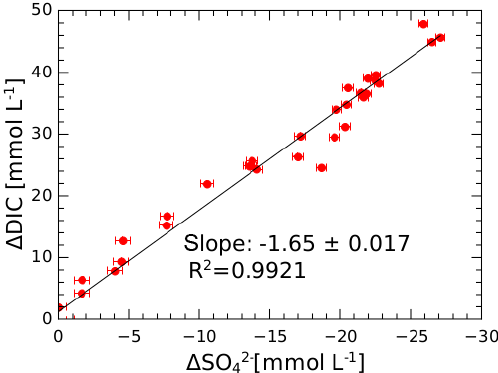
Figure 10. Scatter plot of (cid:49) DIC vs (cid:49) SO 2 − with linear regression. 4 (cid:49) designates the difference between the corresponding porewater and bottom water concentration. The slope of the correlation is − 1.65 ± 0.017 with a correlation coefficient of r 2 =